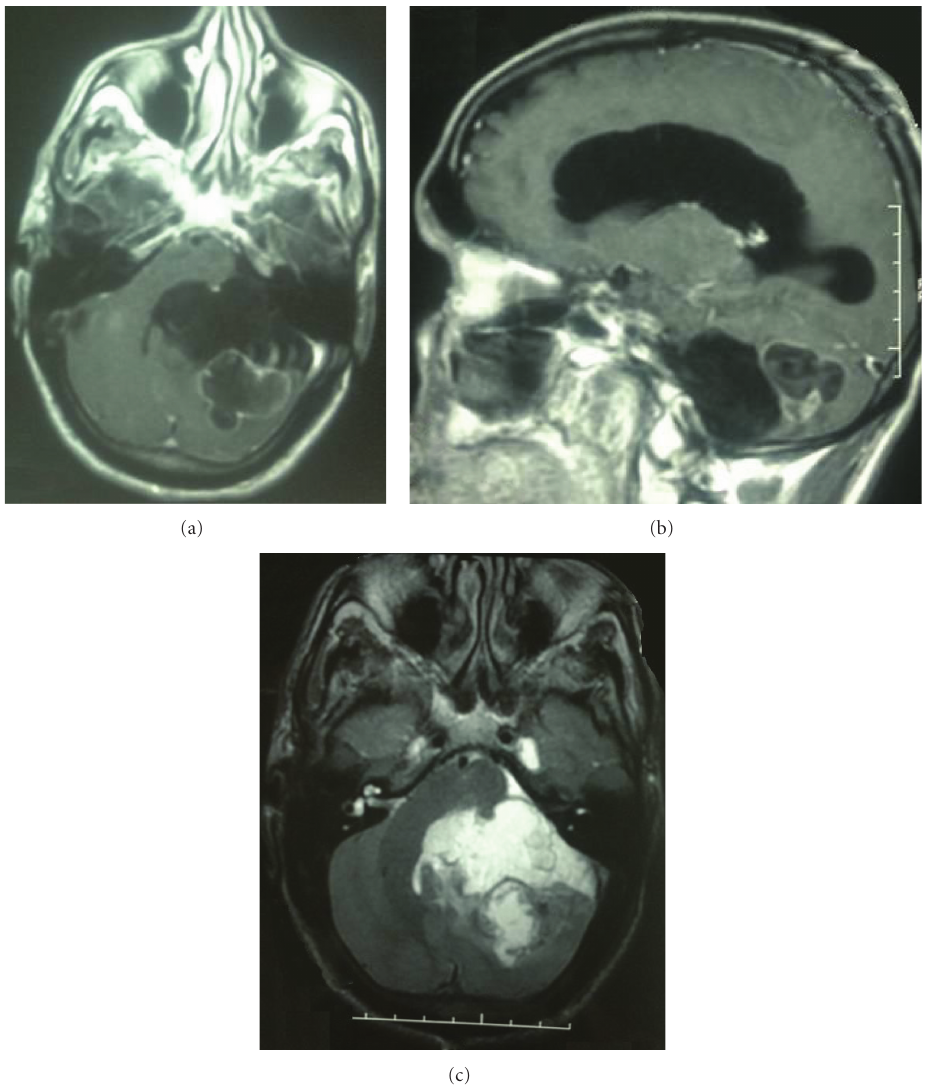
Figure 1: Axial (a) and sagittal (b) T1-weighted MRI with gadolinium and axial (c) T2-weighted MRI before surgery revealing a large cystic lesion of left CPA with enhancement of lower portion of the lesion and severe compression of forth ventricle and